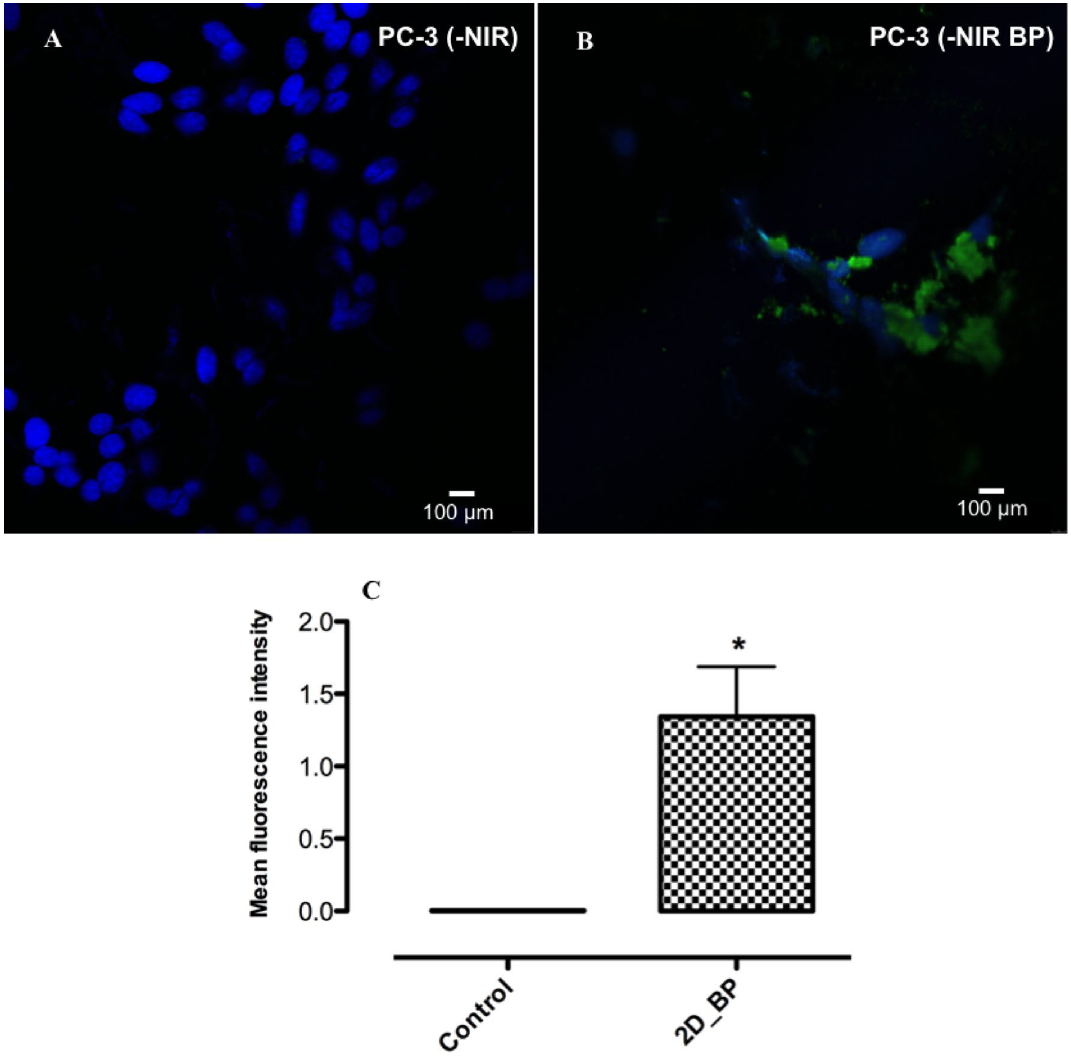
Figure 7. Effect of not irradied (-NIR) 2D BP on qualitative p53 expression in PC-3 cells (immunofluorescence). P53 expression in PC-3 cells in absence ( A ) and in presence ( B ) of 2D BP exposure (5 μg/mL) for 72 h. The images are representative of three experiments. The fluorescence intensity was expressed as mean of fluorescence intensity ± SD (* p ≤ 0.05 vs Control = PC-3 cells without 2D BP